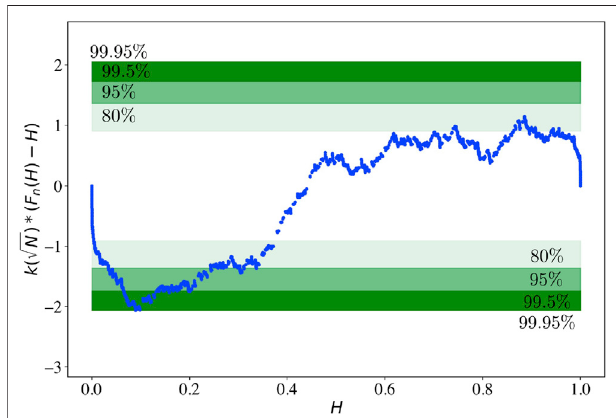
FIGURE 5 | Results of the Bi-test. Deviations from Poisson behavior in the cumulative distribution function for KSMMA catalog. The corresponding 80 % ,95, 99.5 ,and99.95 % probabilitythatagivenvalueisnotconsistentwith the Poisson hypothesis is highlighted by the shaded